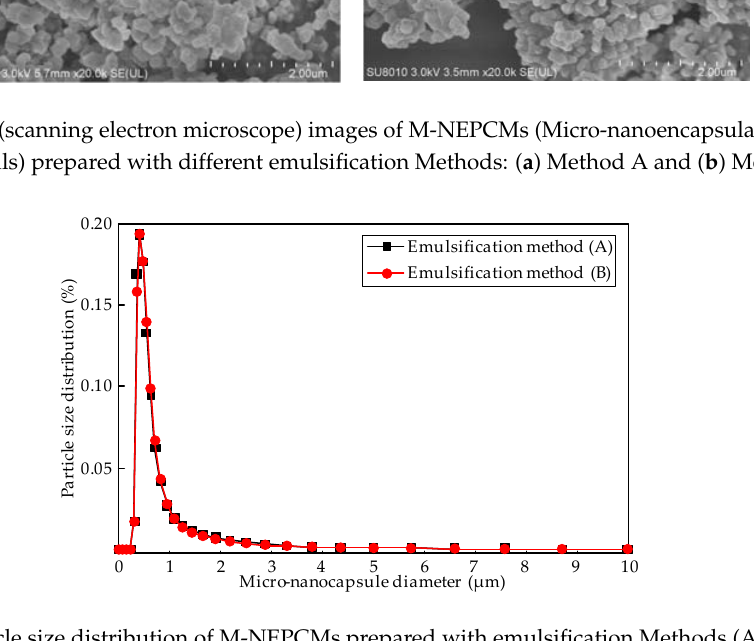
Table 3. Thermal properties of M ‐ NEPCMs prepared with different emulsification methods.